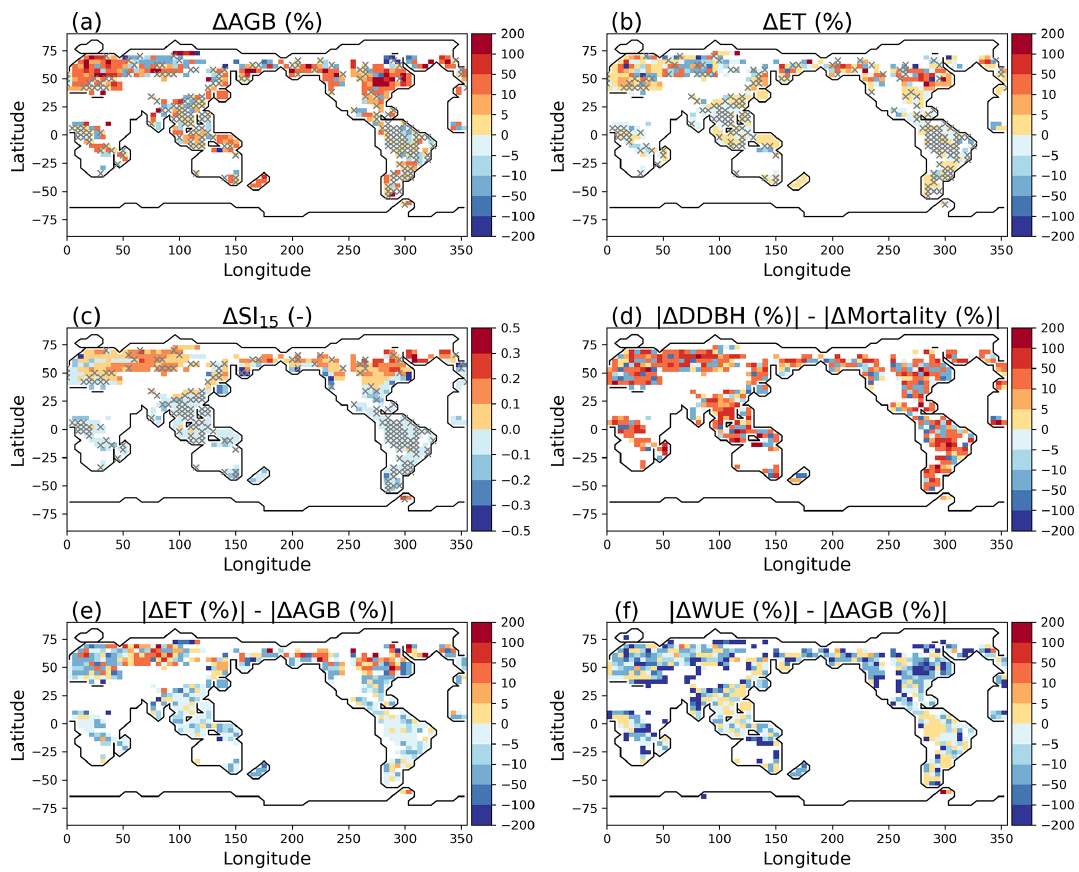
Figure 3. Model difference resulted from layer aggregations: percent change of AGB (Experiment − Reference) (a) and percent change of ET (b) , average soil water saturation between soil layer 1 and layer 5 in simulation year 100 (c) for the Reference simulation, relative change of growth compared to the relative change of mortality (d) , relative change of ET compared to the relative change of AGB (e) , and relative change of WUE compared to the relative change of AGB (f) . The pixels in white on land have values beyond the limits of the legends, associated with AGB < 0 . 5gCm − 2 . Pixels with symbol × have (cid:49) AGB less than